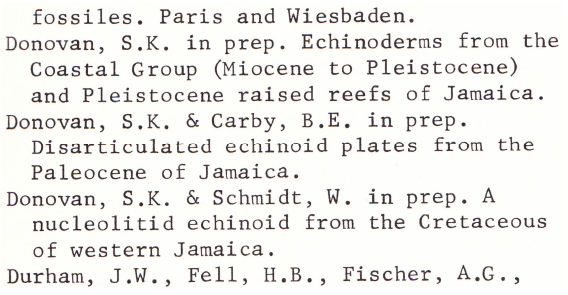
Figure 1. Three papers ‘in preparation’ from the reference list in [4]. Only one of these papers was completed in the form indicated here and published in a timely manner [5]. See text for fuller explanation.